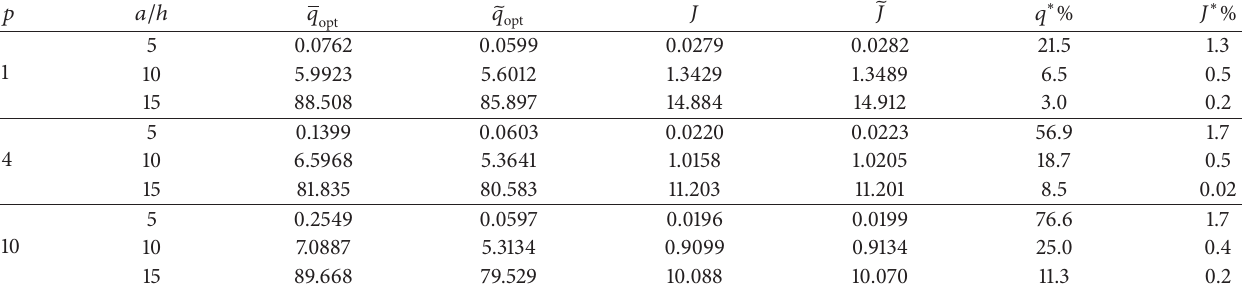
̃𝐽 , ̃𝑞 , 𝐽 , and of simply supported square Al/ZrO 2 FG plates with 𝑚 = 2, 𝑛 = 1 opt opt